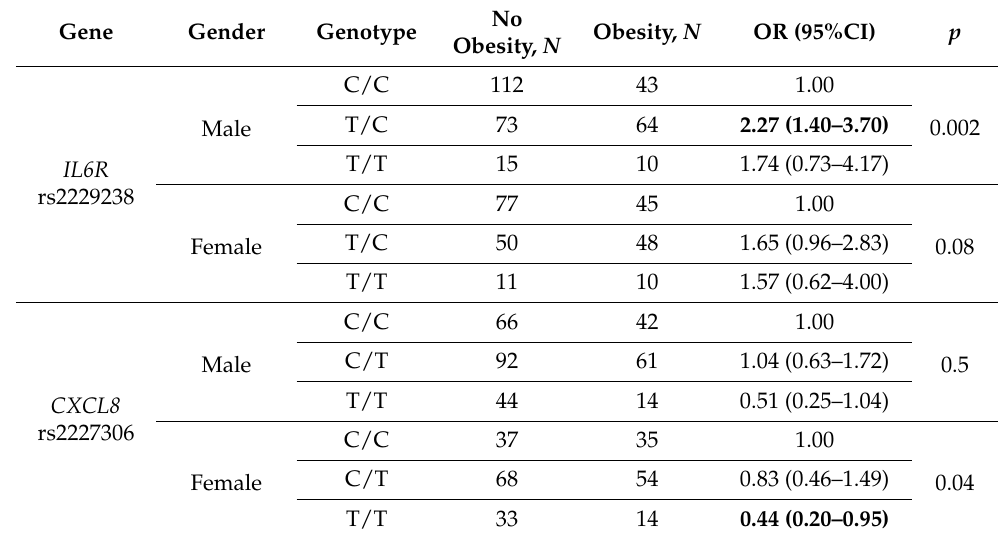
Table 4. Association of SNPs with risk of obesity in groups stratified by